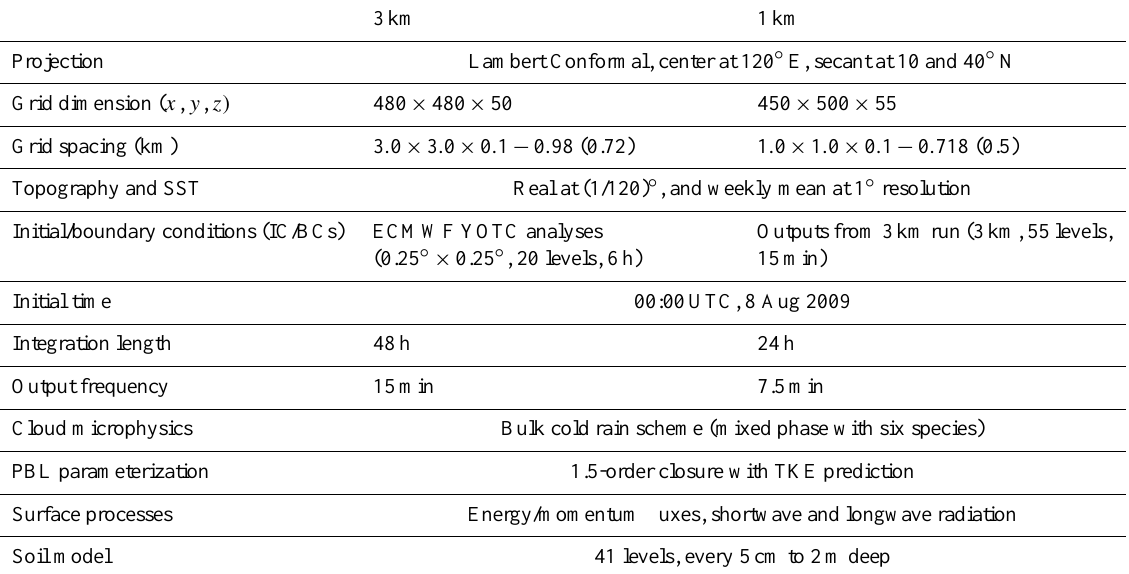
Table 2. Domain configuration, physics, and experiment design used in this study. In the vertical, the grid spacing ( (cid:49)z) of the CReSS model is stretched (smallest at the bottom), and the averaged spacing is given in the parentheses. 3km 1km Projection Lambert Conformal, center at 120 ◦ E, secant at 10 and 40 ◦ N Grid dimension ( x , y , z) 480 × 480 × 50